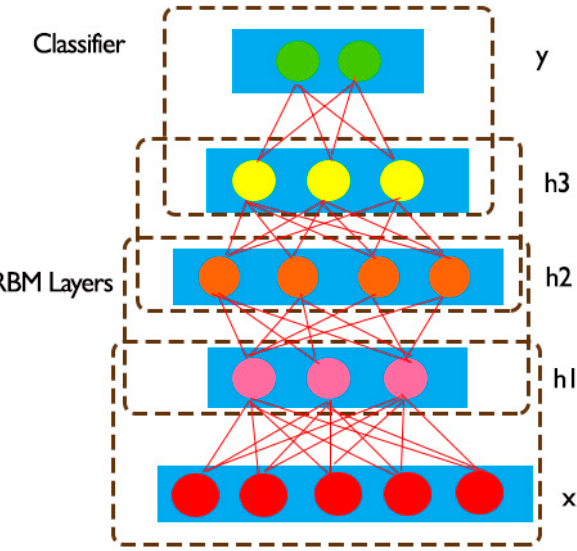
Figure 11. An architecture of deep belief network (DBN). Table 6. DBN-based methods used for fault bearing diagnosis research comparison. Refs.